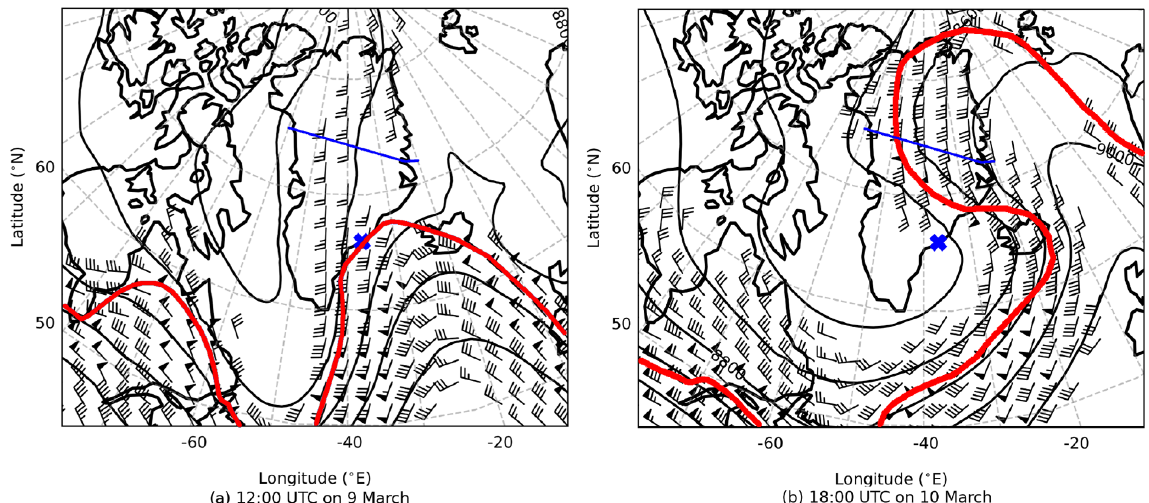
Figure 1. ERA5 geopotential heights and winds at 300hPa valid for 9 March at 12:00UTC (a) and 10 March at 18:00UTC (b) . Only wind speeds greater than 20ms − 1 are plotted. One full barb represents 10ms − 1 and half a barb 5ms − 1 . The red line represents the approximate (excluding eddies and local fluctuations) 4 potential vorticity units ( × 10 − 6 m 2 Ks − 1 kg − 1 ) line. The blue cross will be referred to in Sect. 3.3. The blue solid line represents the flight section used for GLORIA retrieval.